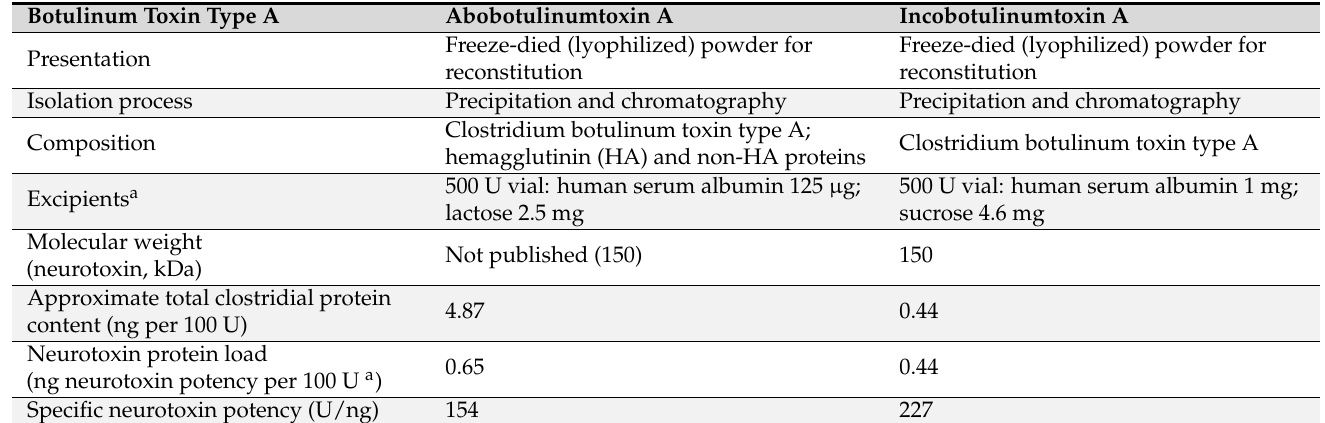
Table 2. Comparison of the two commercial formulations of abobotulinum A and incobotulinum A toxin.